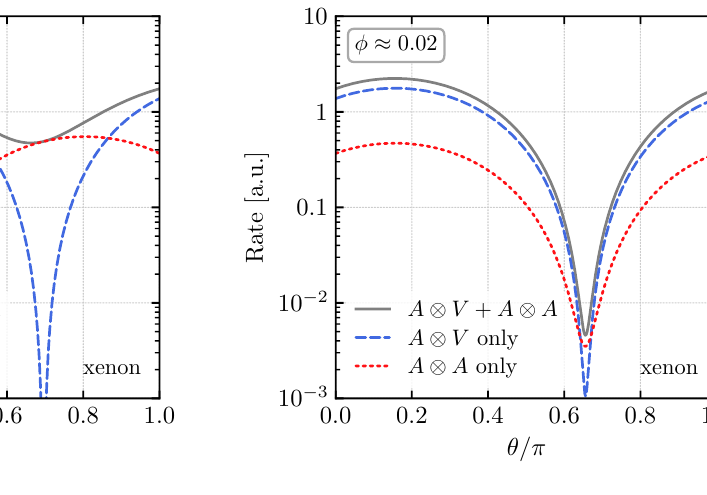
(a) Contours of the relative direct-detection event rate in the θ − φ plane using the parame- terisation of eq. (2.6). The thick horizontal lines correspond to the isospin limit.